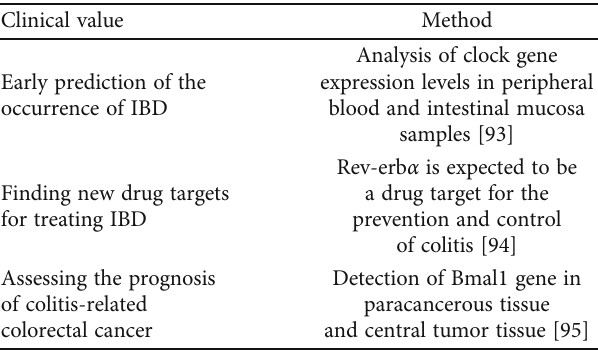
Table 1: Potential clinical value of clock genes for management of